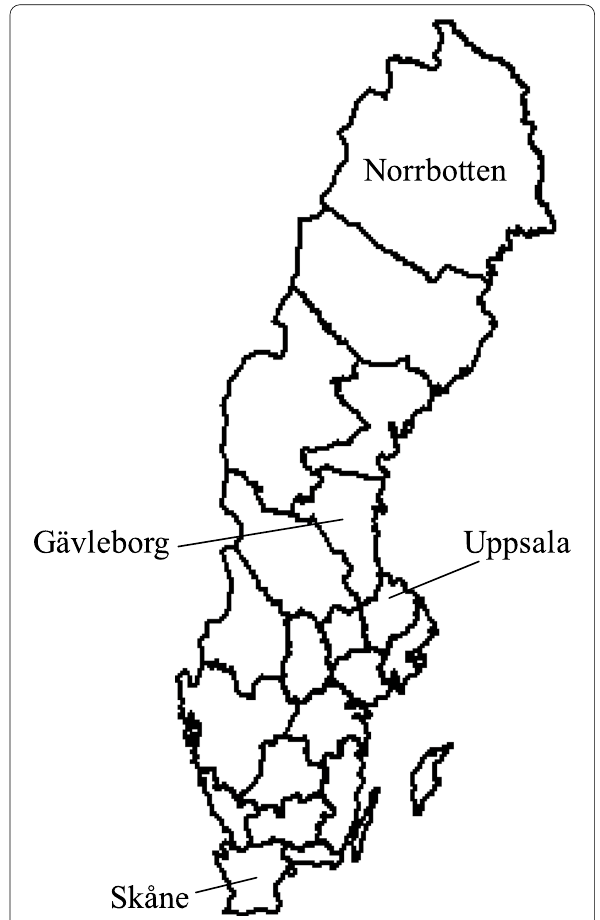
Fig. 3 Map of Sweden illustrating the four studied counties